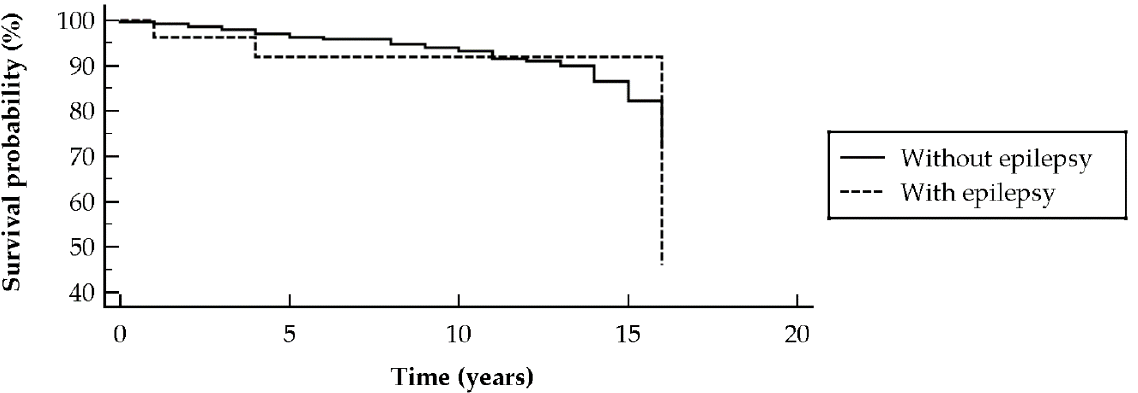
Figure 1. Kaplan–Meier survival curve of dermatomyositis patients with and without epilepsy, showing no significant impact on mortality rate.